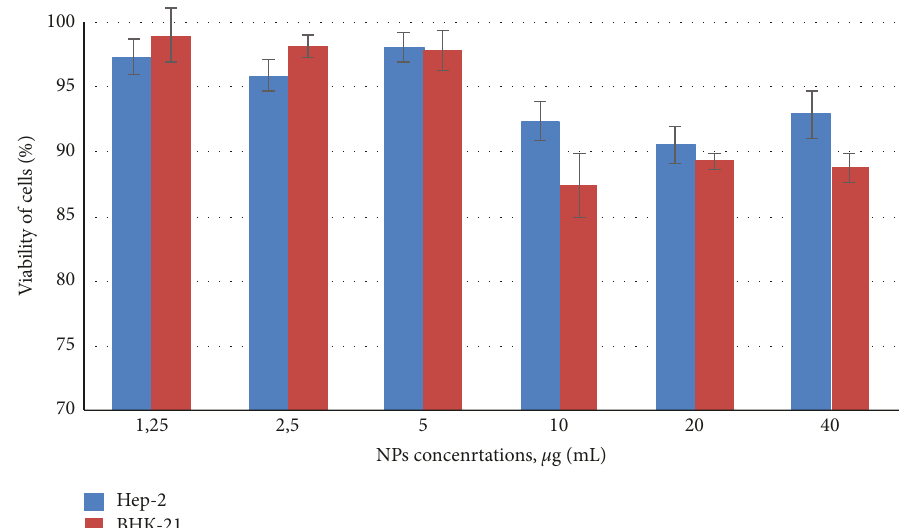
Figure 2: Effect of colloidal coated silver on lysosomal activity of cells. Cytotoxicity of NPs was assessed after 72h exposure on Ofr -2 and BHK-21 cells, evaluated by neutral red uptake (NRU) assay. Control untreated cells − 100% viability. Error bars depict the standard error of the mean. Results show the same lack of effect of nanosilver on cell viability ( p < 0 .